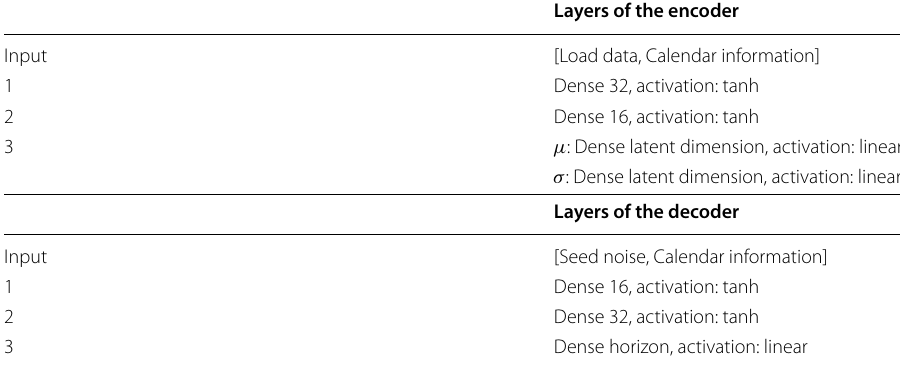
Table 2 The architecture of the encoder and decoder in the used cVAE